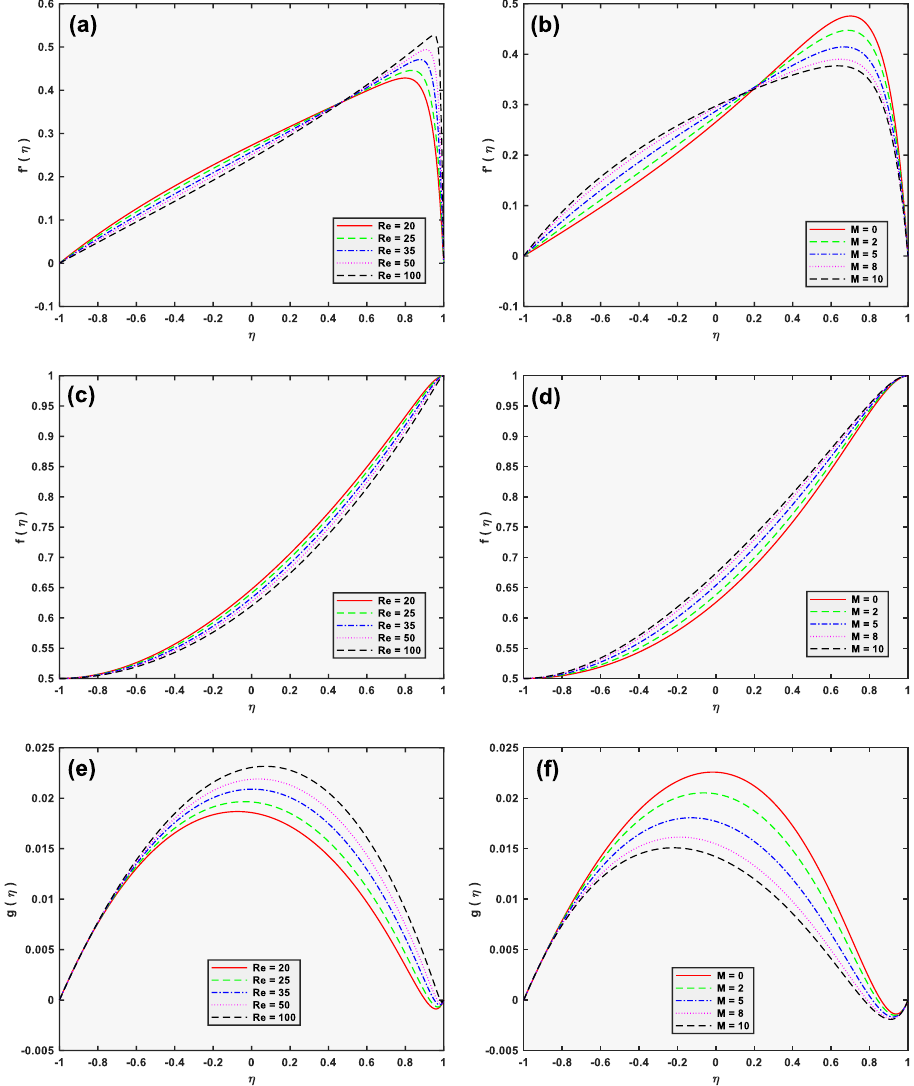
Figure 3. Impact of the Reynolds number Re and the magnetic parameter M on different profiles ( a ) Streamwise velocity with different Re; ( b ) Streamwise velocity with different M ; ( c ) Normal velocity with different Re; ( d ) Normal velocity with different M ; ( e ) Microrotation with different Re; ( f ) Microrotation with different M